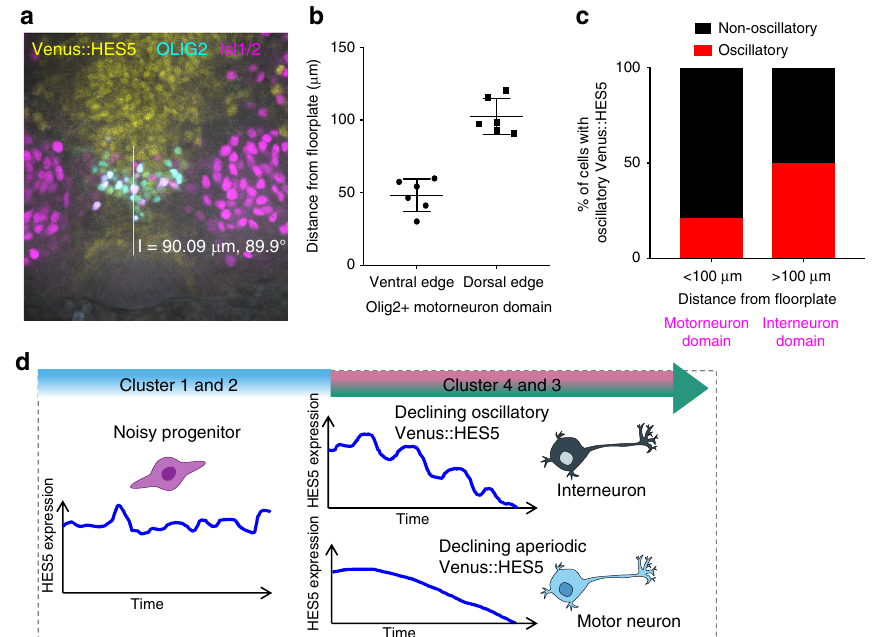
Fig. 8 HES5 oscillations during differentiation correlate with cell fate. a Immuno fl uorescence of E10.5 Venus::HES5 transverse slice of spinal cord ex vivo. Endogenous Venus::HES5 signal, OLIG2 — motor neuron progenitors, Isl1/2 — mature motor neurons. Measurement bar from fl oorplate to dorsal edge of OLIG2 domain 90 μ m. b Distance of ventral and dorsal edge of the motor neuron domain measured from the fl oorplate in ex vivo spinal cord slice cultures. Bars indicate mean and error bars indicate SD n = 6 slices. c Percentage of single cells in clustera 3 and 4 classi fi ed as having oscillatory Venus::HES5 protein expression <100 and >100 μ m from fl oorplate. All cells ( n = 121) and experiments ( n = 3) combined. Fisher ’ s exact test performed on cell numbers in each category, p = 0.004. d Model of Venus::HES5 expression dynamics through cell-state transition from neural progenitor cell to neuron. Neural progenitors have dynamic, noisy and aperiodic fl uctuations in Venus::HES5 protein expression. As cells transition towards neurons they have a long-term decreasing trend in Venus::HES5 and are more likely to show short-term oscillatory dynamics. Cells declining with oscillatory Venus::HES5 correlate with interneuron fate, whereas declining non-oscillatory cells correlate with motor neuron fate. Source data are provided in a Source Data fi